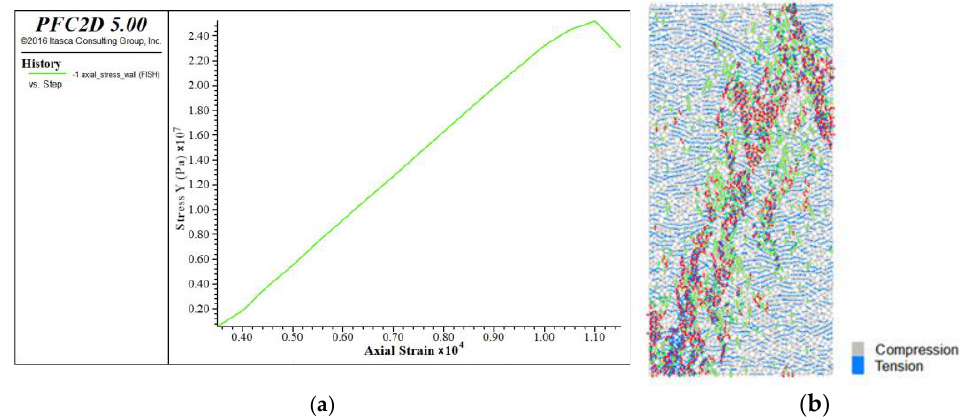
Figure 13. Parameter calibration of uniaxial compression magnification factor ratio. ( a ) stress strain curve, ( b ) break mode.